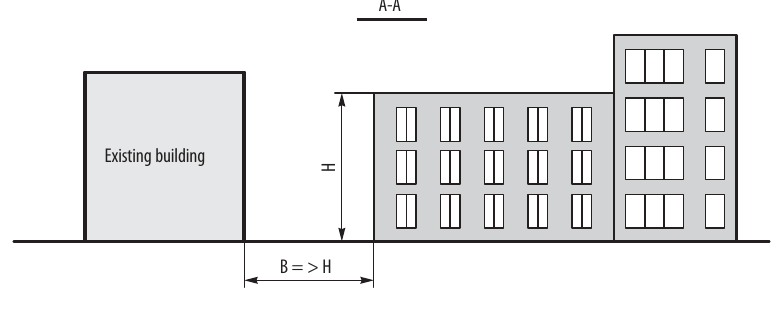
Figure 3. Cross-section